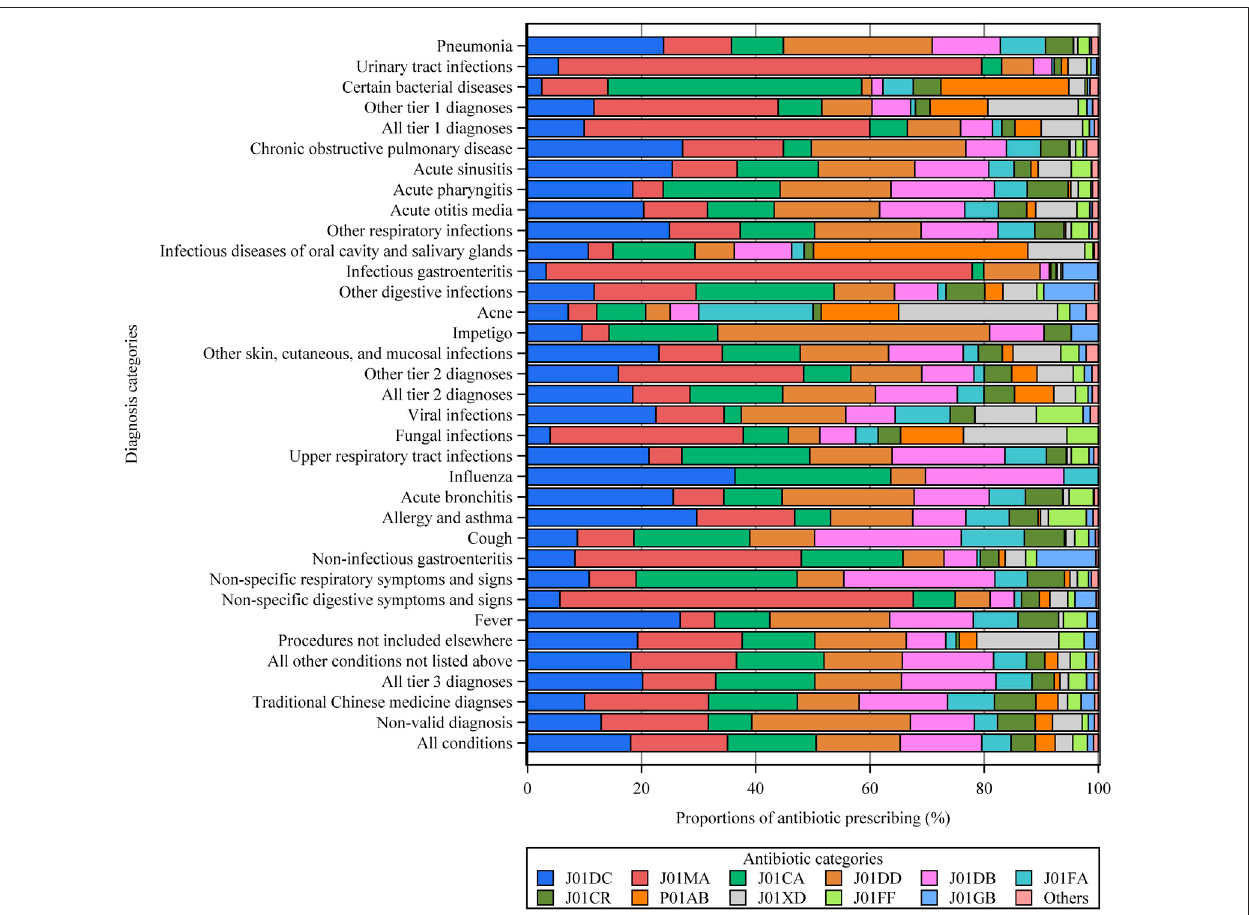
FIGURE3| Typesofantibioticsprescribedfordifferentdiagnosticcategories.Othertier1diagnoses=othertier1bacterialinfections.Otherrespiratoryinfections= other infectious diseases of the respiratory system categorized in tier 2. Other tier 2 diagnoses = other tier 2 infectious diseases for which an antibiotic may be indicated. See the Supplementary Table S2 for more details on all the diagnostic categories. J01CA = penicillins with extended spectrum. J01CR = combinations of penicillins, including beta-lactamase inhibitors. J01DB = fi rst-generation cephalosporins. J01DC = second-generation cephalosporins. J01DD = third-generation cephalosporins. J01FA = macrolides. J01FF = lincosamides. J01MA = fl uoroquinolones. J01GB = other aminoglycosides. J01XD = imidazole derivatives. P01AB = nitroimidazole derivatives. Others = include J01AA, J01CE, J01CF, J01EB, J01EE, and